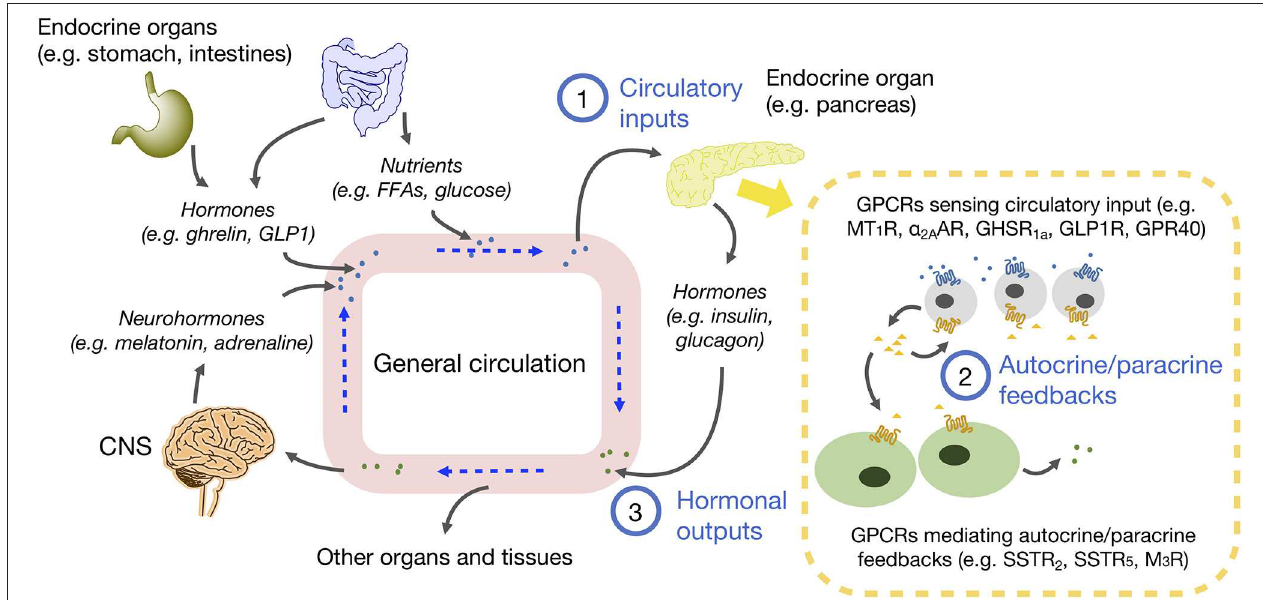
FIGURE 1 | Schematic diagram of endocrine, autocrine, and paracrine communications in energy homeostasis. Circulating molecules such as neurohormones, hormones and nutrients are derived from CNS, endocrine organs and tissues, and small intestine. These molecules in blood are circulated to different parts of the body. The molecules diffused into endocrine organs act as circulatory inputs (1), which then bind to receptors on target cells and trigger the secretion of autocrine and paracrine factors, so as to foster communications between the same or different cell types (2). As a result of signal integration from various autocrine/paracrine factors, hormone secretions from endocrine cells are adjusted, and hormonal outputs are released into the circulation (3), which can further influence other organs and tissues to maintain homeostasis.